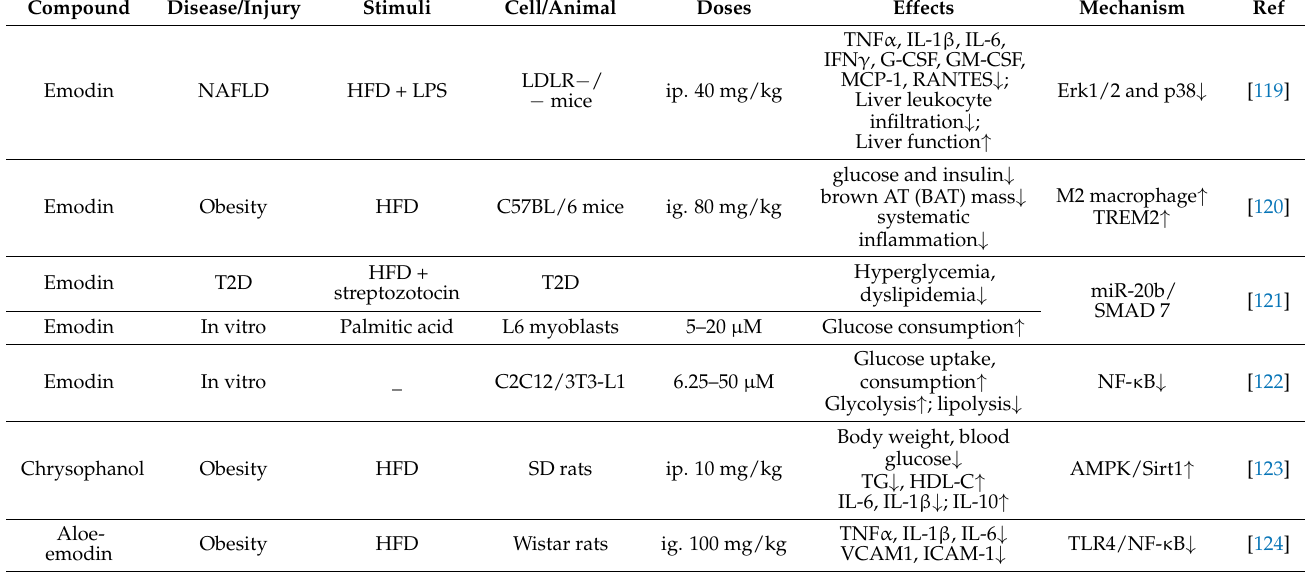
Table 5. Effects and mechanism of AQs on metabolic